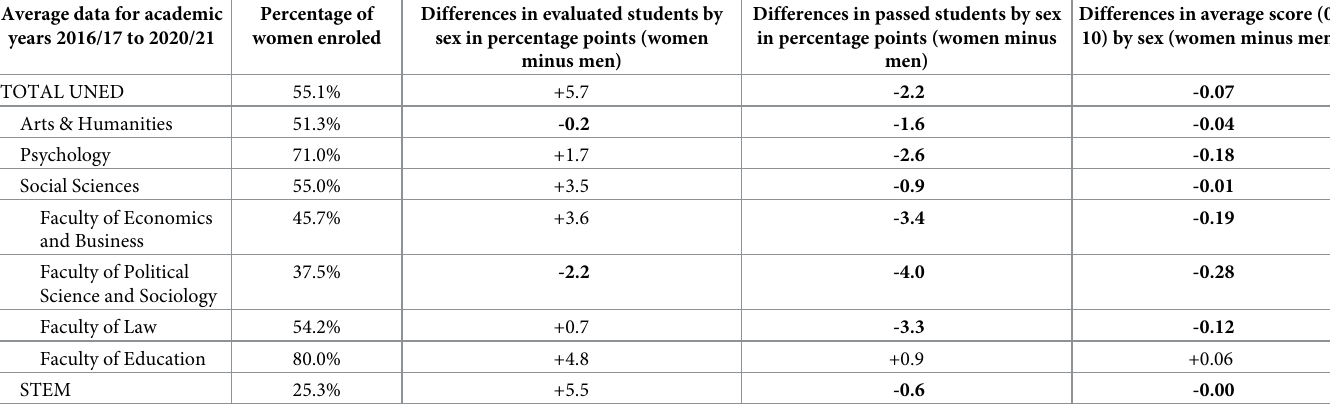
Table 1. Female participation and gender gap in educational outcomes by field of education at UNED